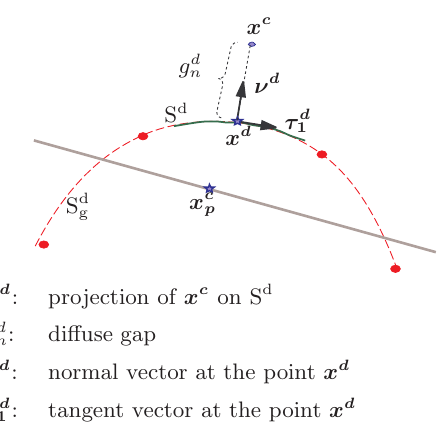
Fig. 7. Diffuse gap (2D